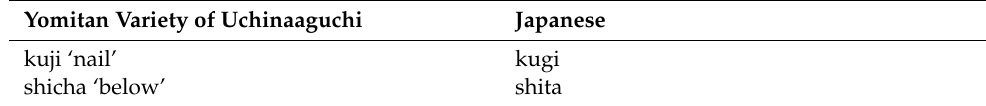
Table 5. Example words showing